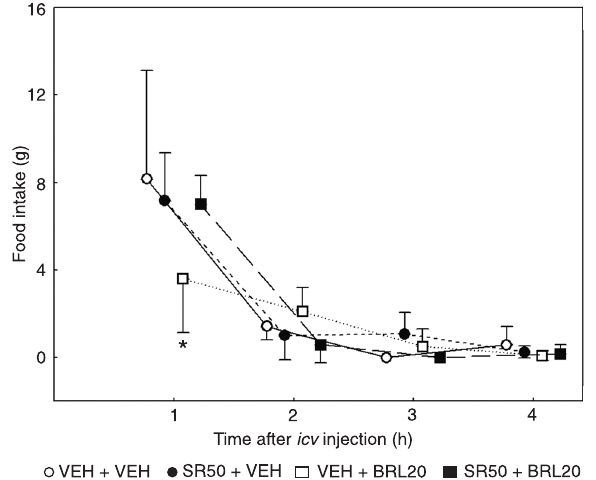
Figure 3. Effects of icv injection of 20 nmol BRL37344 (BRL20, a β 3 -adrenergic receptor agonist) in rats fasted for 24 h and pretreated with the antagonist of the β 3 -adrenergic receptor [SR59230A (SR50) at a dose of 50 nmol] or vehicle (VEH, saline). Data are reported as means ± SEM. *P < 0.05 compared to the group that received microinjection of vehicle (one-way ANOVA followed by the Duncan post hoc test for multiple comparisons).